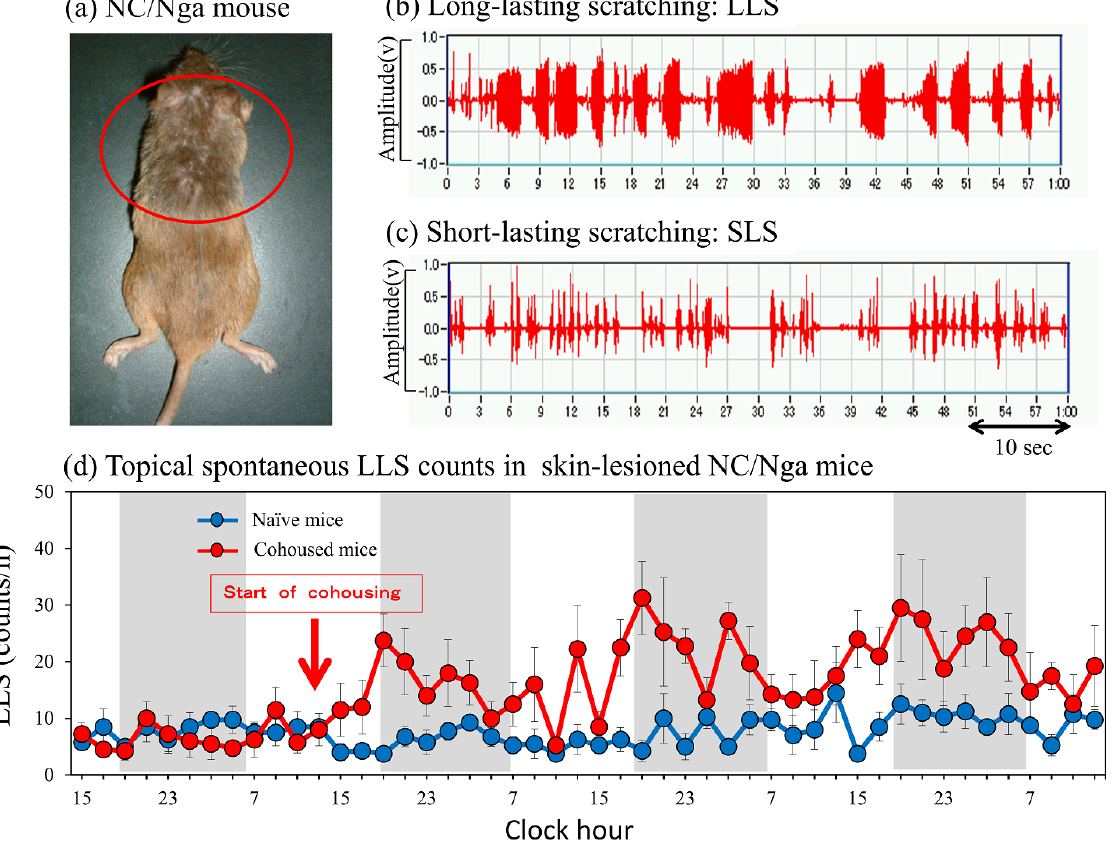
Figure 1. Scratching behavior of skin-lesioned NC/Nga mice. ( a ) Skin − lesioned NC/Nga mice, an animal model of atopic dermatitis. NC/Nga mice with spontaneous skin lesions frequently scratch their faces, ears, and rostral parts of their backs (inside the red circle) using their hind paws. Dermatitis also does not develop in the lower part of the mouse body, which is not accessible to its hind paws. ( b ) Representative form of long-lasting scratching (LLS, scratching behavior that lasts more than 1.5 s, itch-associated scratching behavior). ( c ) Representative form of short-lasting scratching (SLS, scratching behavior that lasts from 0.3 to 1.5 s, associated hygiene behavior). ( d ) LSL counts of SPF-NC/Nga mice cohoused with skin-lesioned NC/Nga mice. Red arrow indicates the start of cohousing with skin-lesioned NC/Nga mice, the lateral axis indicates the clock hour, and the shaded area represents nighttime (dark phase, 7:00 p.m. to 7:00 a.m.). Touch- or brush-evoked pruritus around an itching site is termed “itchy skin” or “alloknesis,” whereas pin-prick-evoked itching sensations around an itching site are termed “hyperknesis” [18]. Patients with chronic itching may perceive nonpruritic stimuli, such as electrical, noxious heat pain, or scratching stimuli distal to itchy stimuli, as itchy [19,20].